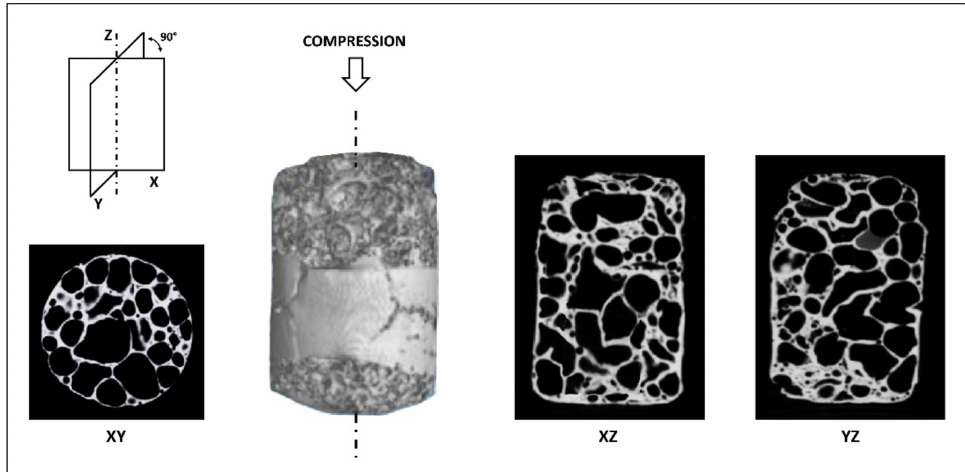
Figure 2. CT images (rendering, XY cross sections, XZ and YZ longitudinal sections) of the reference specimen (0.4% TiH 2 foam) used for model fitting, at Step 0